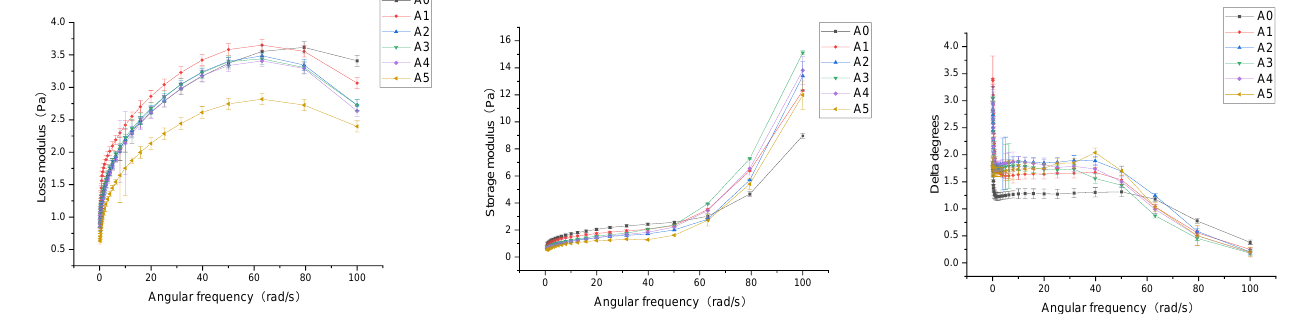
Figure 2. Variations in storage modulus ( G ’ ), loss modulus ( G ’’ ), and delta degrees of CLB in a dynamic frequency scan. Three independent measurements were made on each sample and results were presented as the mean with error bars representing the standard deviation. In the figure, A0: not homogenized; A1: 4000 rpm; A2: 8000 rpm; A3: 12,000 rpm; A4: 16,000 rpm; A5: 20,000 rpm.